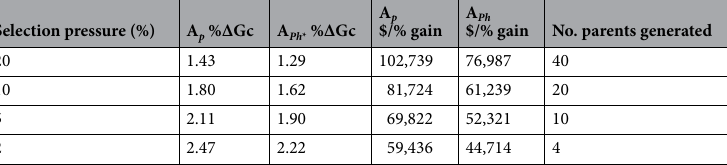
among and within family selection pressures of 20%/10% (among/within family), 10%/5%, 5%/1% and 2%/1%, were applied at each level of accuracy r A (0.26, 0.36, 0.46). Cycle 1 consisted of 3 years. Cycle 2 (C2) (Table 4) used genomic selection for both the among and within family selection (A gs W gs ) applying selection pressures of 20%/10% and 10%/5%. Cycle 2, a single year, was based on 100 HS families each taken from the 2000 HS and 500 HS families generated in C1 at selection pressures of 20%/10% and 10%/5%, respectively. In addition to r A values of 0.26, 0.36 and 0.46, an additional level of accuracy, r A of 0.12, was applied in C2 to model a scenario of declining accuracy due to decay of genetic relationships (Table 4). In C1 (Table 3), the predicted %ΔG per cycle rose as r A was increased. In this cycle, the combination of increasing among HS family phenotypic selection pressure (2%) and within family genomic selection pres- sure (1%), at high r A (0.46), resulted in the highest ΔG of 6.35%, based on data from the A p seasonal herbage DM yield sampling method. The cost per percentage gain was a low $27,397 compared to the high $111,819 at among and within HS family selection pressures of 20% and 10%, respectively, at r A of 0.26. However, while the low selection pressures and r A resulted in the selection of 400 parents, the high selection pressure and r A lead to identifying only 4 parents (Table 3). As expected, the predicted ΔG per cycle, under the A Ph strategy phenomics assessments of seasonal herbage DM in C1, was slightly lower than A p , but there was a substantial increase in cost efficiency per % genetic gain (Table 3). Cycle 2 (Table 4) was based on genomic selection among and within (A gs W gs ) 100 HS families generated from selected parents from C1 at 20%/10% and 10%/5% selection pressure and at r A values of 0.26, 0.36 and 0.46. In C2, ΔG was estimated relative to the new mean of HS progeny generated from C1, within each combination of % selection pressure and r A . The predicted ΔG per cycle ranged from 2.05% at r A 0.26 to 3.59% at r A 0.46, at among and within family selection pressures of 20%/10%. Applying higher selection pressures (10%/5%) at r A values of 0.26 and 0.46, increased the range of predicted ΔG per cycle to 2.44% and 4.27%, respectively. Predicted ΔG combined across selection C1 and C2 resulted in totals ranging from 4.93% to 7.58% at r A 0.26 and 0.46, respectively, at among and within selection pressures of 20%/10% (Table 4). At the same r A values of 0.26 and 0.46 at among and within HS family selection pressures of 10%/5%, the predicted ΔG combined across cycles C1 and C2 were 5.93% and 9.06%, respectively. Comparing the costs per percentage predicted ΔG, combined across cycles C1 and C2, the total of $148,418 at r A 0.26 and 20%/10% among and within family selection pressures was